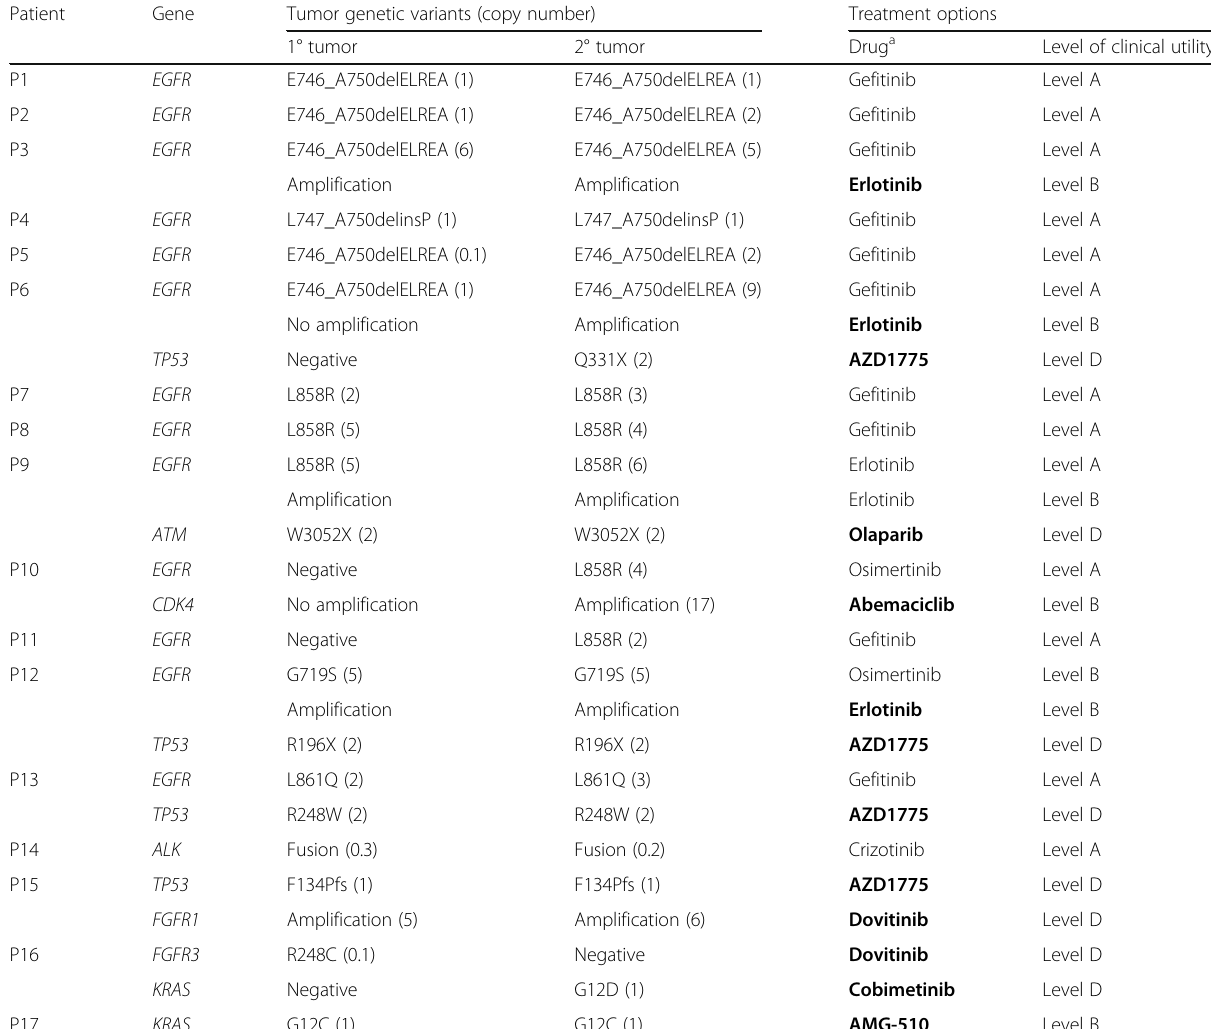
Table 2 Treatable genetic variants and level of clinical utility Patient Gene Tumor genetic variants (copy number) Treatment